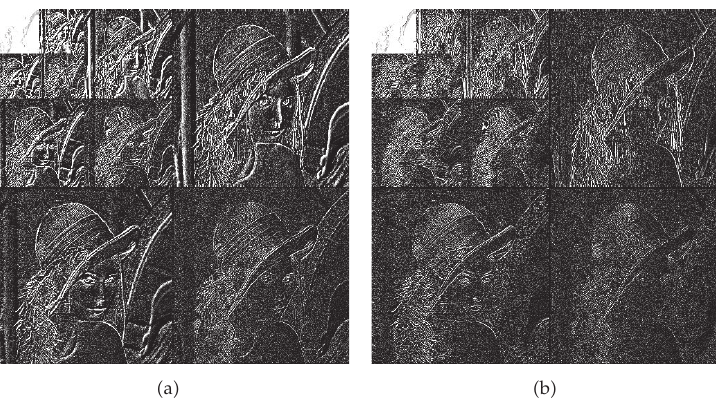
Figure 1: It shows that the high-frequency subbands by the derived filter can reveal more features than that by the commonly used tensor-product wavelet filter. (cid:3) a (cid:4) Decomposition of the “Lena” image by the derived filter. (cid:3) b (cid:4) Decomposition of the “Lena” image by tensor-product filter. All the coe ffi cients in the high-frequ- ency subbands are magnified by a factor 20 to see the di ff erence.